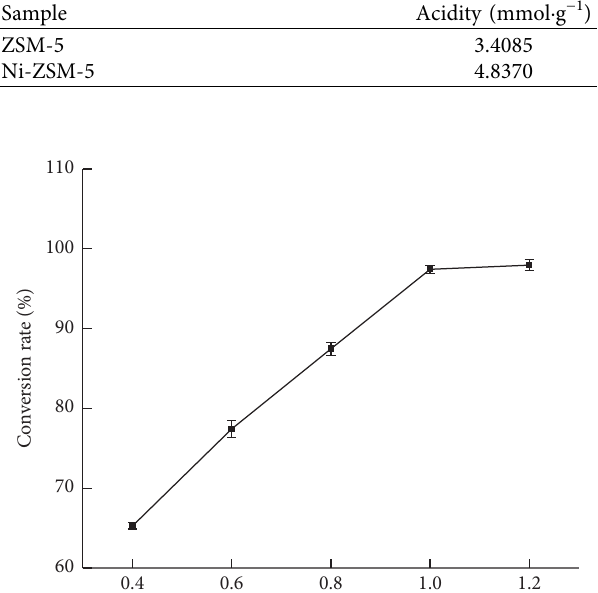
Table 4: Acidity of ZSM-5 and Ni-ZSM-5 catalysts.